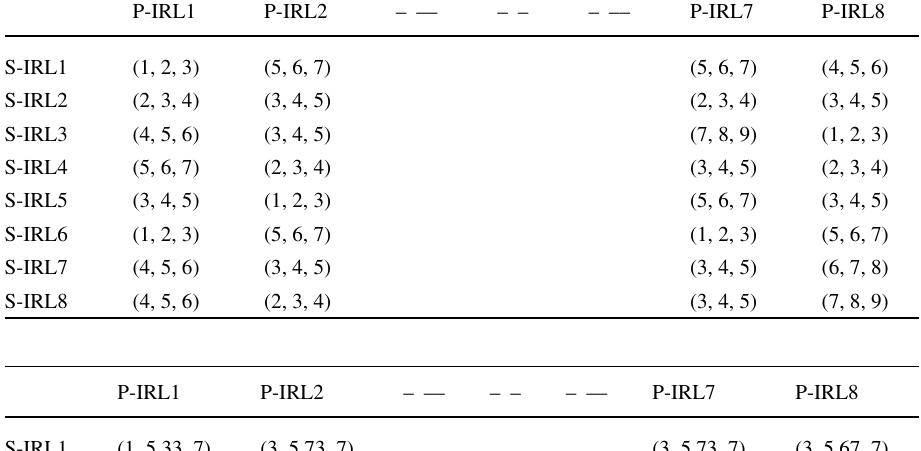
Table 10 Aggregated fuzzy TOPSIS evaluation matrix for solutions